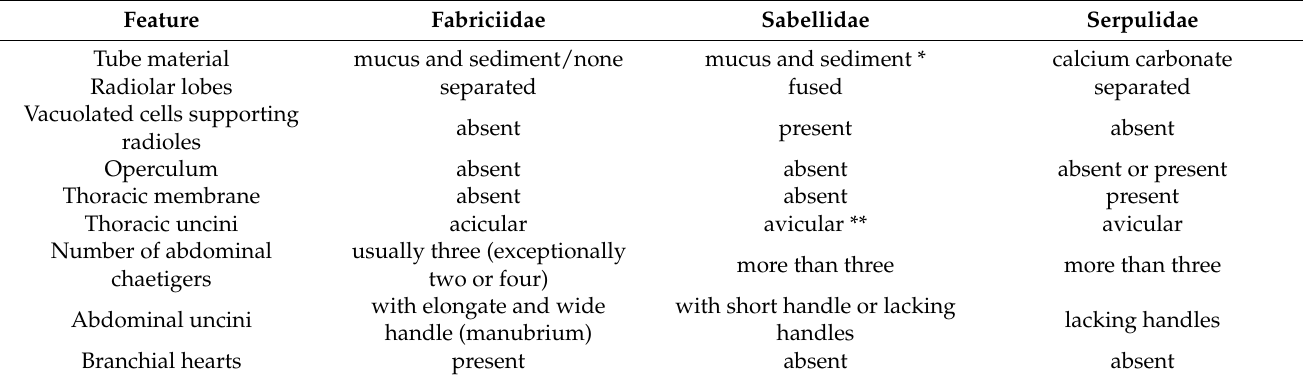
Table 1. Morphological diagnostic features of the three taxa of